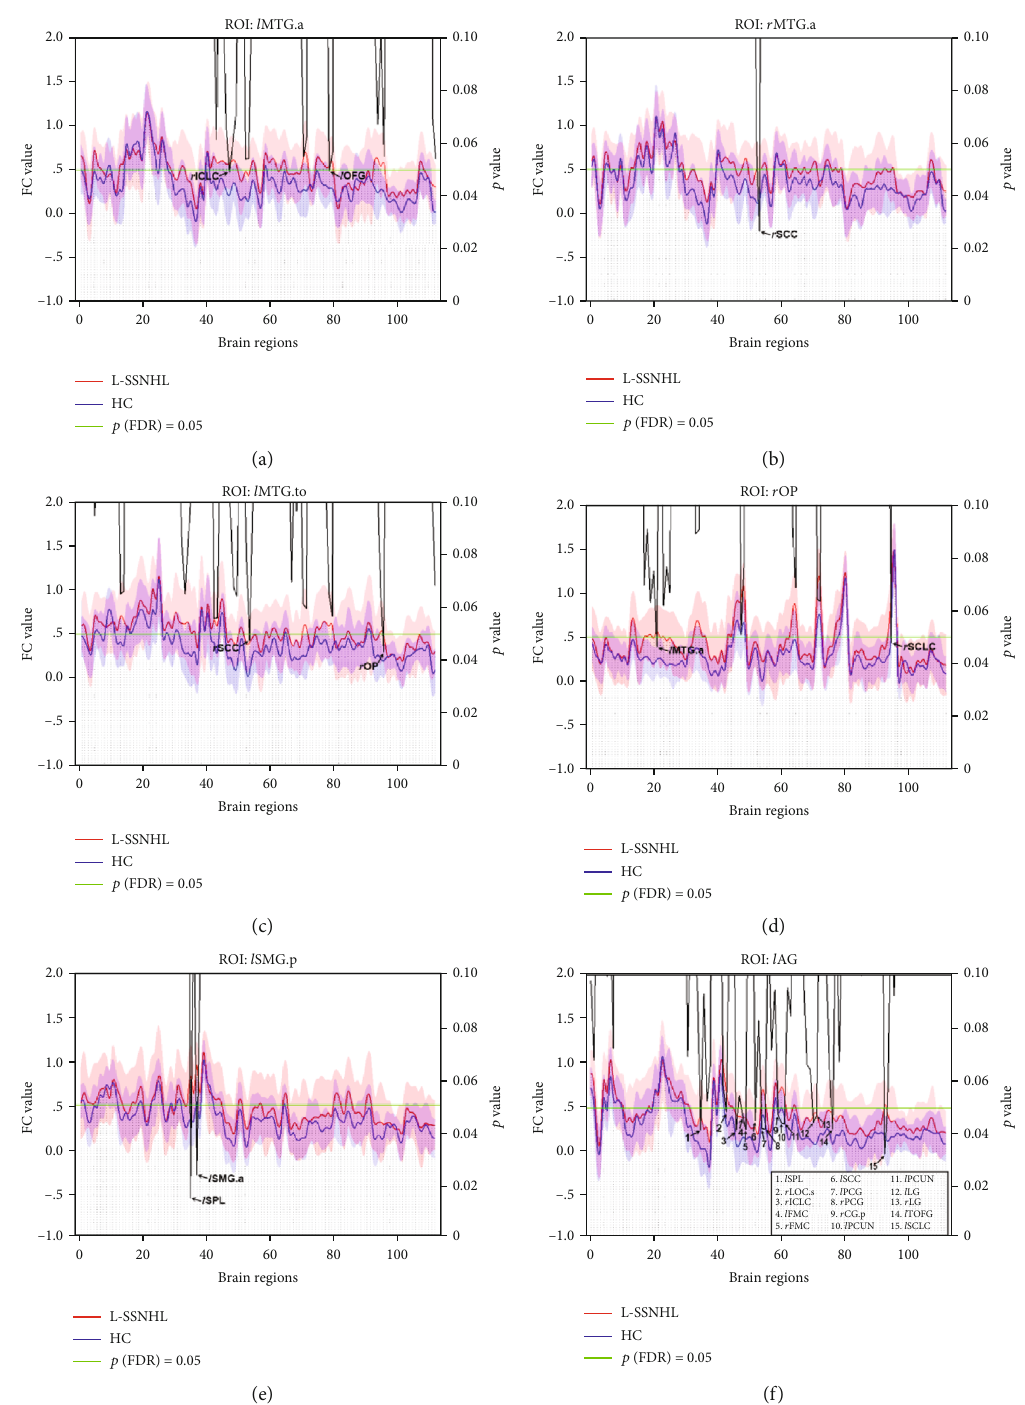
Figure 4: Intergroup comparisons of ROI-wise FC between the L-SSNHL and HC-1 subgroups. Compared with the HC-1 subgroup, the L-SSNHL subgroup showed signi fi cantly increased FCs between (a) the l MTG.a and the r ICLC and l OFG, (b) the r MTG.a and the r SCC, (c) the l MTG.to and the r SCC and r OP, (d) the r OP and the l MTG.a and r SCLC, (e) the l SMG.p and the l SPL and l SMG.a, and (f) the l AG and 15 ROIs indicated in the legend. MTG: middle temporal gyrus; OP: occipital pole; SMG: supramarginal gyrus; AG: angular gyrus; ICLC: intracalcarine cortex; OFG: occipital fusiform gyrus; SCC: subcallosal cortex; SCLC: supracalcarine cortex; SPL: superior parietal lobule; LOC: lateral occipital cortex; FMC: frontal medial cortex; PCG: paracingulate gyrus; CG: cingulate gyrus; PCUN: precuneus; LG: lingual gyrus; TOFC: temporal occipital fusiform cortex; l : left; r : right; a: anterior division; p: posterior division; s: superior division; to: temporooccipital